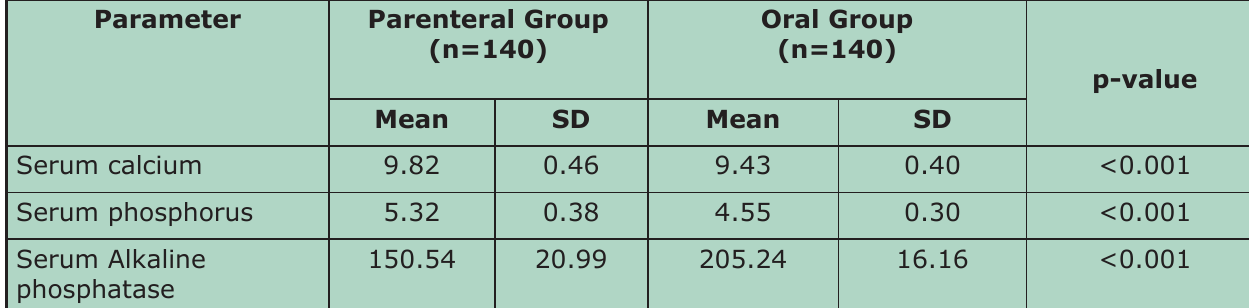
Table-III: Comparison of parental and oral vitamin D supplementation in the treatment of nutritional rickets after treatment (n=280).